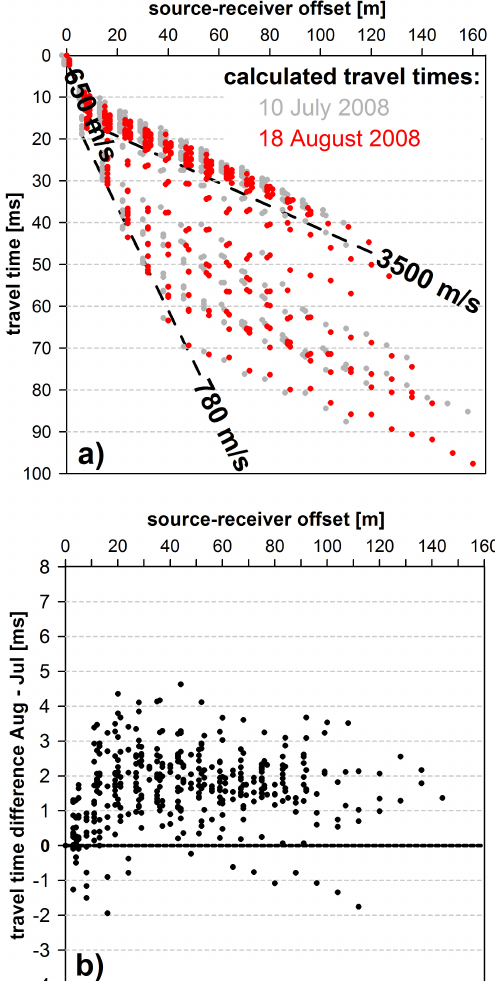
Fig. 14. As in Fig. 5, but now for (a) calculated travel times from the tomographic result (in Fig. 8) against source-receiver offset, (b) differences in calculated traveltimes against